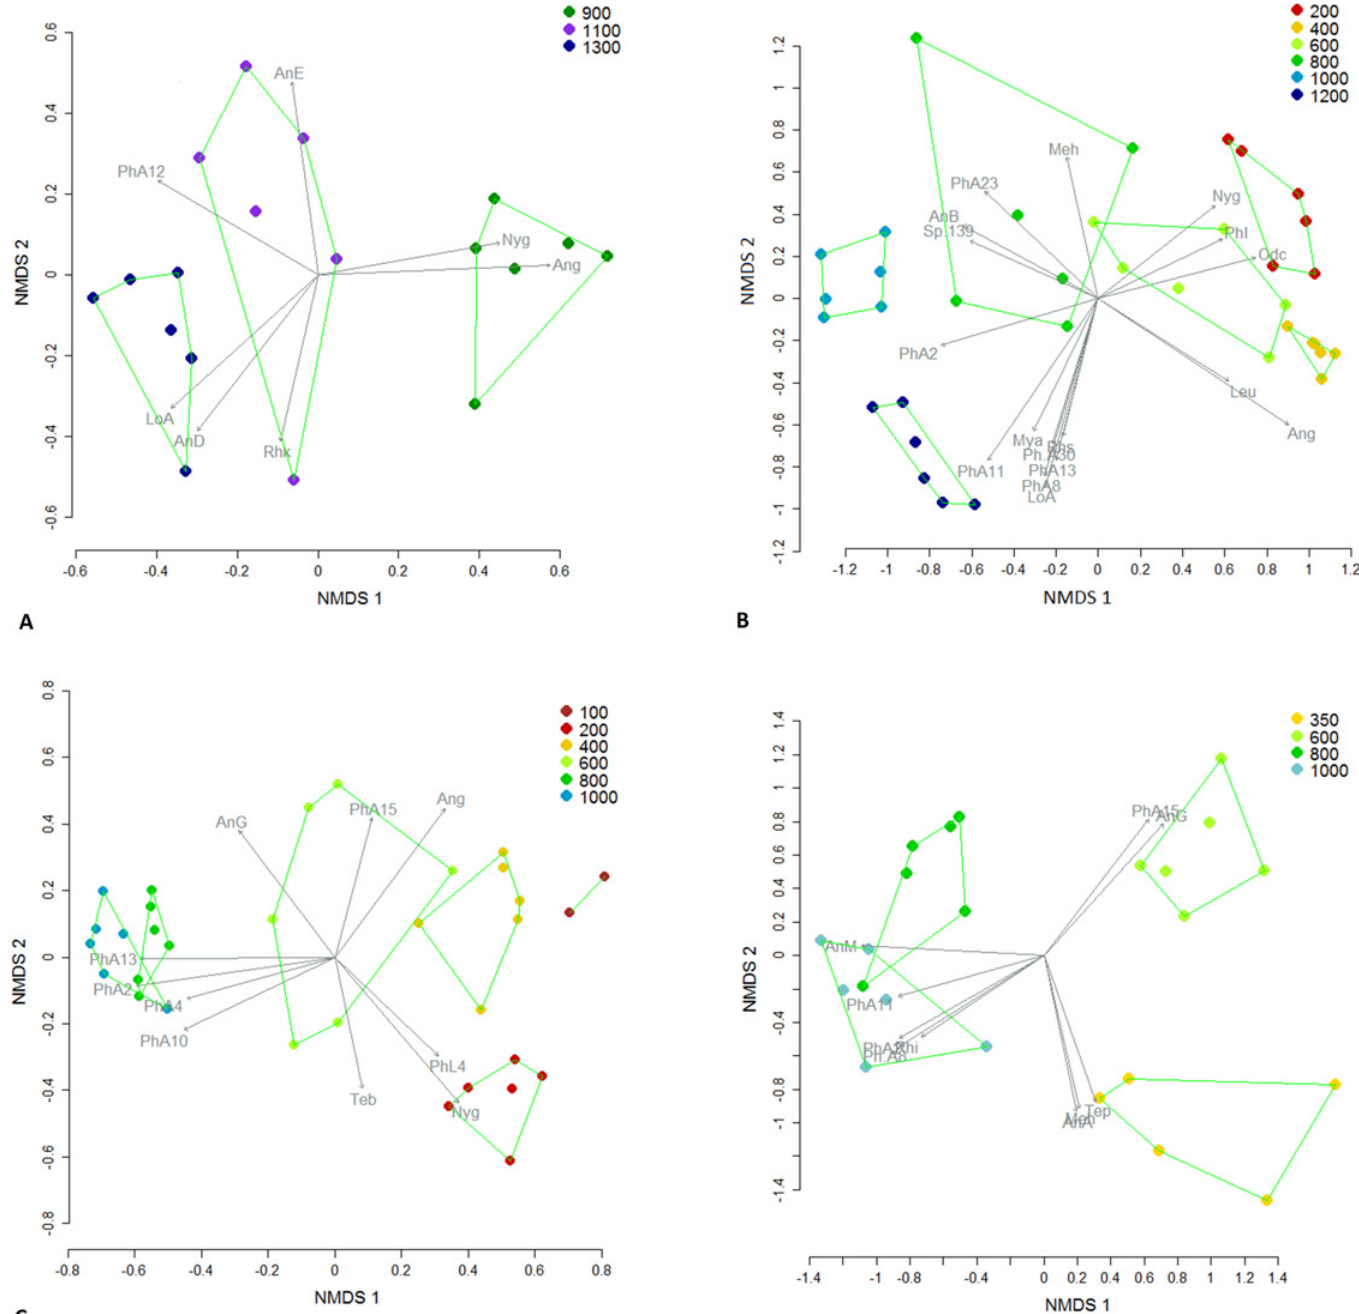
Fig 7. A-D. NMDS of ant community composition in plots at the four main subregions, based on species frequencies from pooled data across all four sampling periods. Significantly different (P < 0.01) communities are shown by convex hulls. Significantly correlated (P < 0.01) species are represented by vectors, with vector length proportional to level of significance. Species codes are: Ang = Anonychomyrma gilberti , AnA = Anonychomyrma sp. A nr . gilberti , AnB = Anonychomyrma sp. B ( biconvexa gp.), AnD = Anonychomyrma sp. D ( biconvexa gp.), AnE = Anonychomyrma sp. E ( nitidiceps gp.), AnG = Anonychomyrma sp. G ( nitidiceps gp.), AnM = Anonychomyrma sp. M, CaH = Carebara sp. H, CrH = Crematogaster sp. H, DiB = Discothyrea sp. B, Leu = Leptomyrmex unicolor , LoA = Lordomyrma sp. A ( punctiventris gp.), Meh = Meranoplus hirsutus , MoB = Monomorium sp. B ( nigrius gp.), Myn = Myrmecia nigrocincta , Mya = Myrmecina alpina , Nyg = Nylanderia glabrior , Odc = Odontomachus cephalotes , PhA1 = Pheidole sp.A1 ( ampla gp.), PhA2 = Pheidole sp. A2 ( ampla gp.), PhA4 = Pheidole sp.A4 ( ampla gp.),PhA8 = Pheidole sp.A8 ( ampla gp.), PhA10 = Pheidole sp.A10 ( ampla gp.), PhA11 = Pheidole sp.A11 ( ampla gp.), PhA12 = Pheidole sp. A12 ( ampla gp.), PhA13 = Pheidole sp. A13 ( ampla gp.), PhA15 = Pheidole sp.A15 ( ampla gp.), PhA23 = Pheidole sp.A23 ( ampla gp.), Ph.A30 = Pheidole sp.A30 ( ampla gp.), PhI = Pheidole sp.I1 ( impressiceps gp.), PhF1 = Pheidole sp.F1 (Group F), PhL4 = Pheidole sp.L4